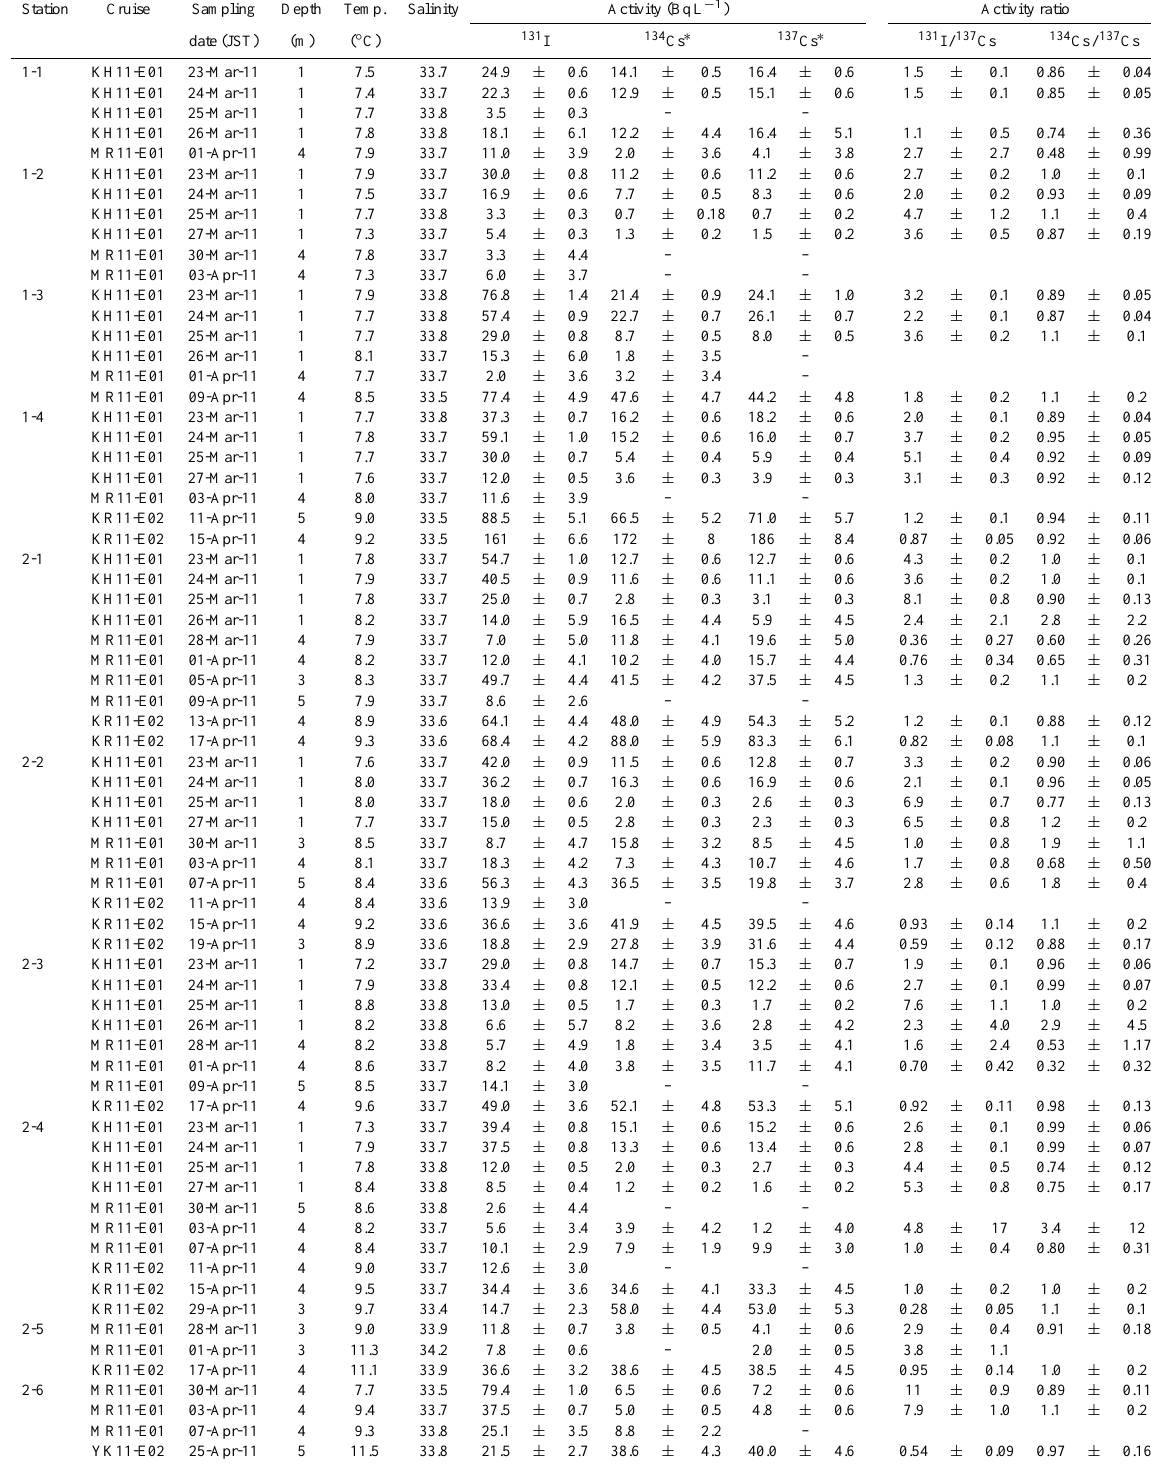
Table 2. Hydrographic parameters, activities, and activity ratios of 131 I, 134 Cs, and 137 Cs in the surface waters during four cruises (i.e., KH11-E01, MR11-E01, KR11-E02, and YK11-E02). Station Cruise Sampling Depth Temp.